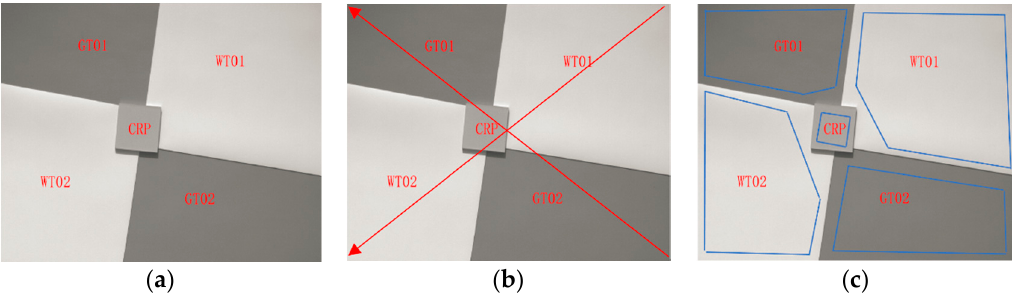
Figure 18. Images obtained by the multispectral camera (Band1 as an example): ( a ) Band1 image of targets; ( b ) diagonal pixels of five spectral images selected for relative accuracy; ( c ) areas selected for analyzing pixel statistics of images.